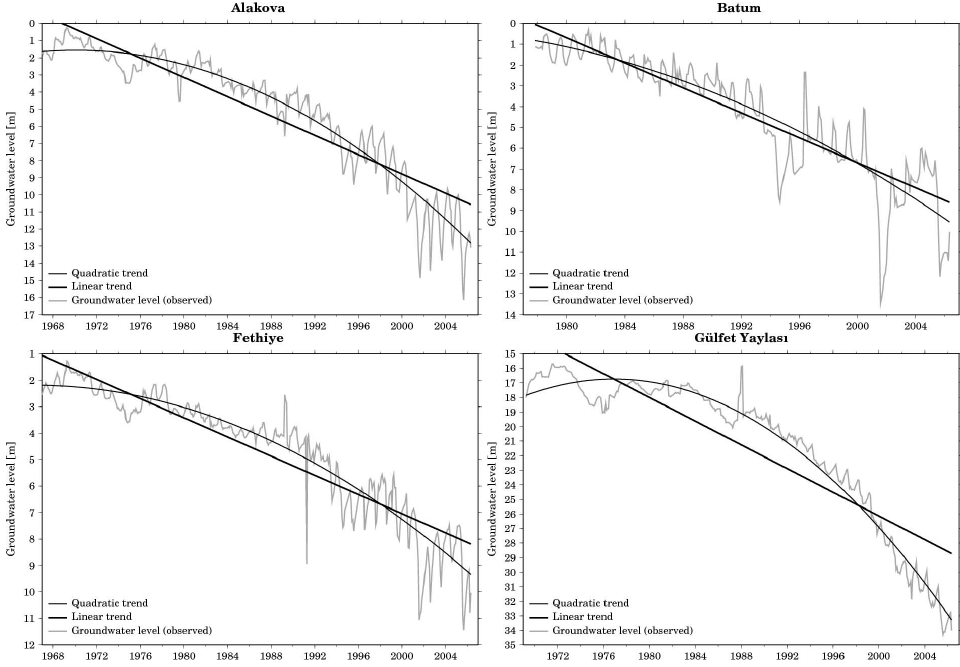
Fig. 2. Observations of water levels (monthly) for selected wells in KCB and their linear and quadratic trends.